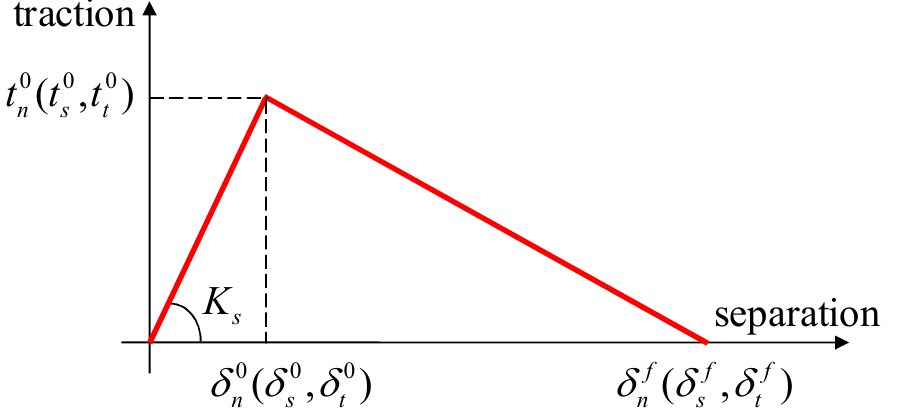
Figure 10. Typical traction-separation constitutive model. The normal stiffness component, K n = 1358 N/mm 3 , and the tangential stiffness com- ponents K s and K r are 20,358 N/mm 3 . The peak values of the traction stress components, the normal contact stress t n and two shear contact stresses t s and t t , are 5.63 MPa. The total plastic displacement is taken to be 0.241 mm.